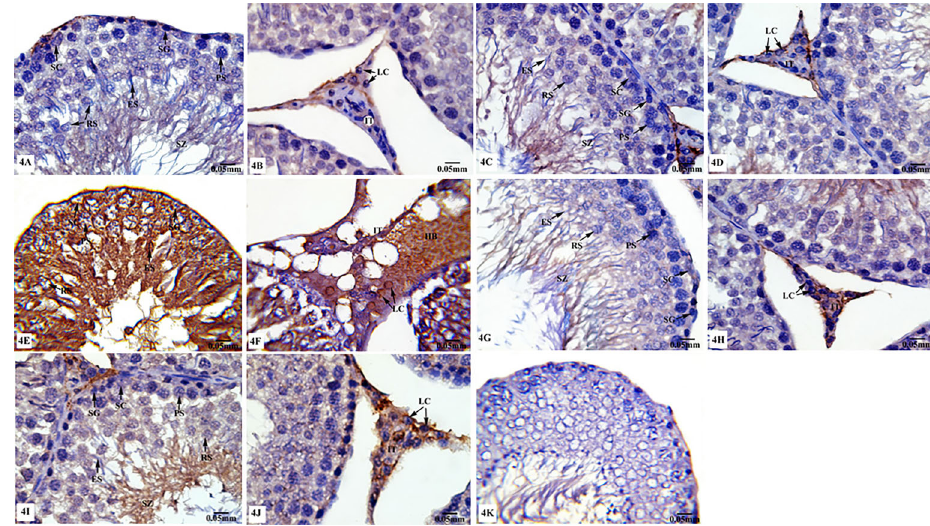
Figure 4. Photomicrographs of testicular tissues of control and experimental animal groups stained for Cas3 immunoreactivity. A and B , control group; C and D , sham group; E and F , taxol (TXL)-treated group; G and H , melatonin (MLT)-treated group; I and J , MLT + TXL- treated group. There was no staining on the negative control sample ( K ). SC: Sertoli cells; SG: spermatogonia; PS: primary spermatocytes; RS: rounded spermatids; ES: elongated spermatids; LC: Leydig cells; IT: interstitium. Scale bar: 0.05 mm.